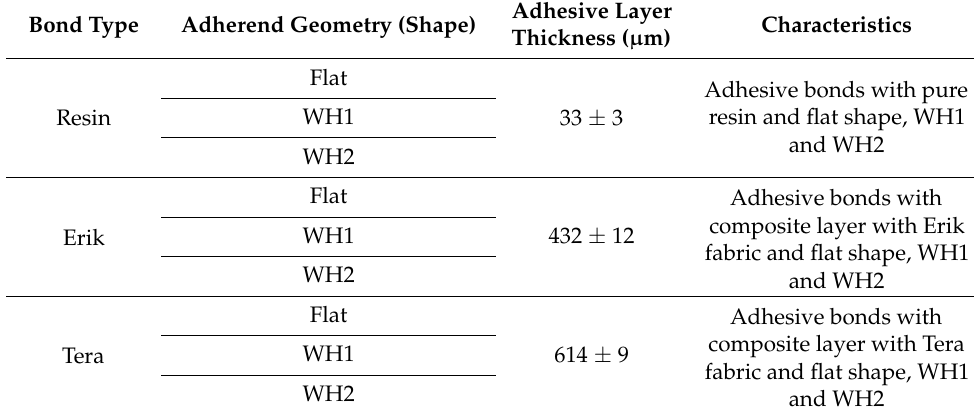
Table 4. Types, shape, and adhesive layer thickness of the hybrid adhesive